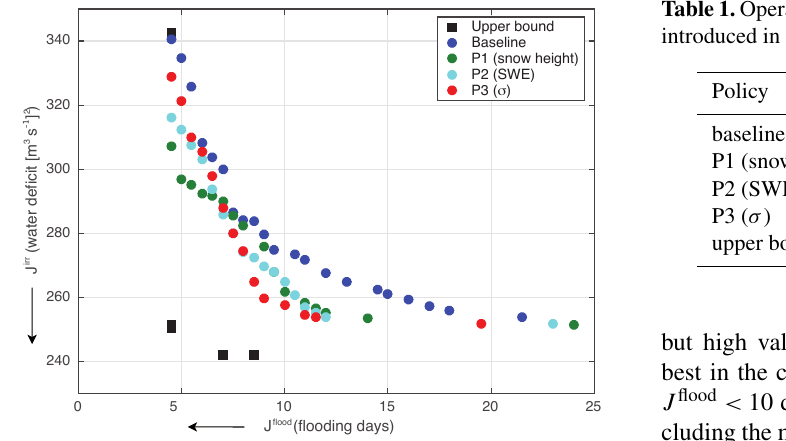
Figure 9. Performance obtained by different Lake Como operat- ing policies informed with ground observations (P1 – green cir- cles), SWE estimated by ARPA (P2 – cyan circles), or virtual snow indexes (P3 – red circles). The performance of these solutions is contrasted with the upper bound of the system performance (black squares) and the baseline operating policies (blue circles).